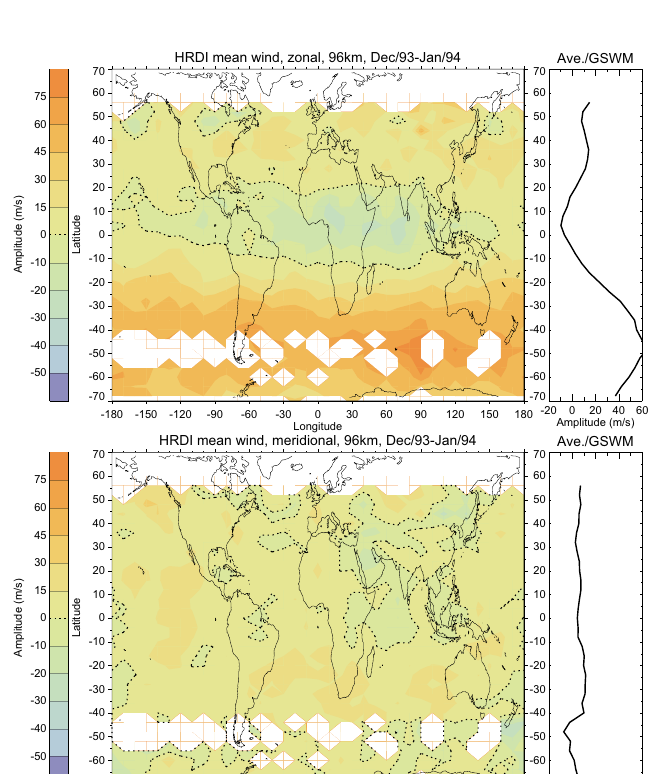
Fig. 11. Mean winds at 96km for June– July 1993.